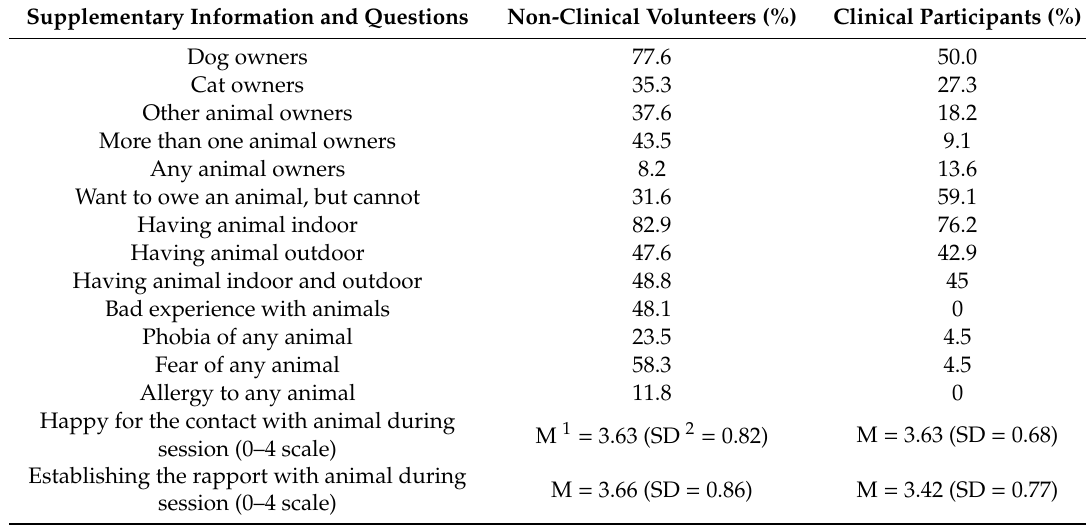
Table 1. Supplementary information and questions.